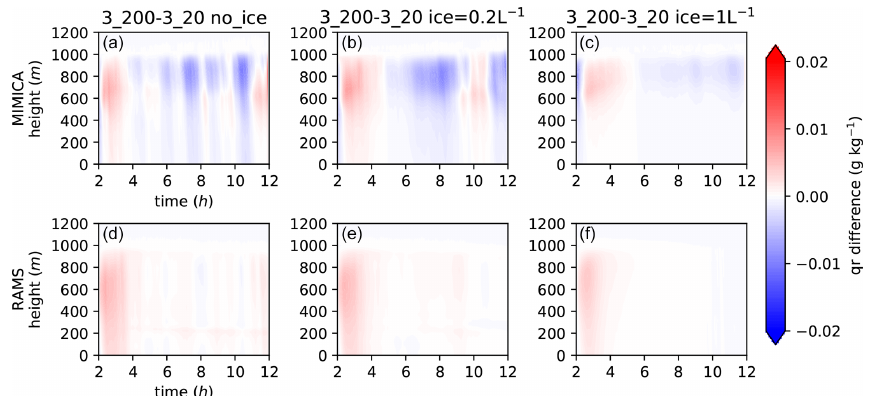
Figure 12. Differences in rain water mixing ratio (qr) for simulation pairs with the same accumulation mode concentration and the same ice crystal concentration equal to 0L − 1 (no_ice; a, d ), 0.2L − 1 (b, e) and 1L − 1 (c, f) , shown for MIMICA and RAMS. The first 2h of simulations, considered as the spin-up period, are excluded. A Student’s t test with a 95% confidence level shows that the (time mean) differences are statistically significantly different for each pair of simulations except for the pair with ice crystal concentration of 1L − 1 in RAMS. For figure clarity, the plot titles have been abbreviated; the first number refers to the accumulation mode and the second to the Aitken mode concentration in cubic centimetres, i.e. 3_20 refers to